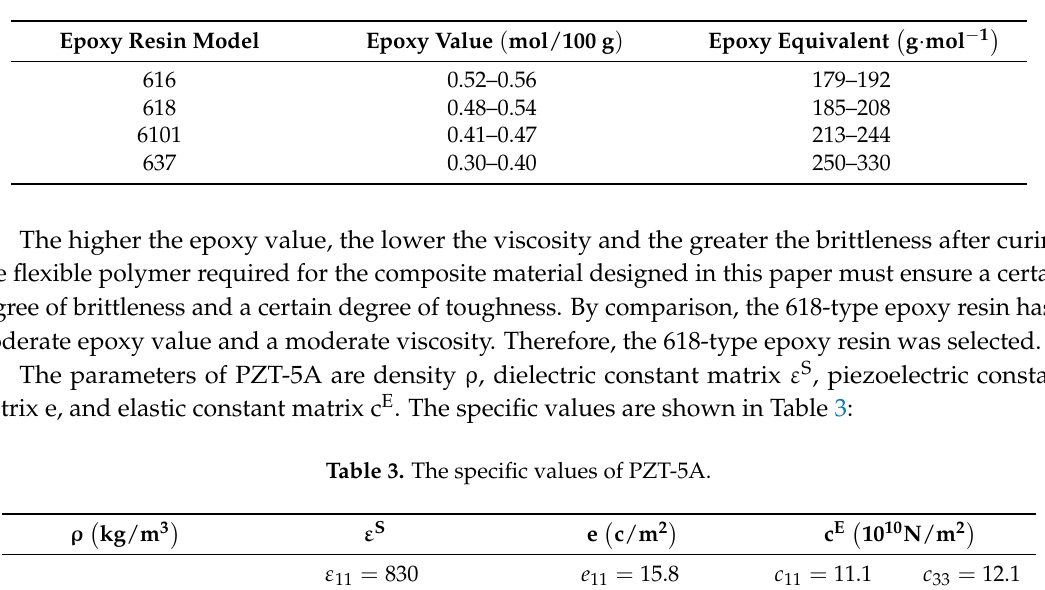
Table 2. The common domestic liquid bisphenol A epoxy resin and the main parameters.